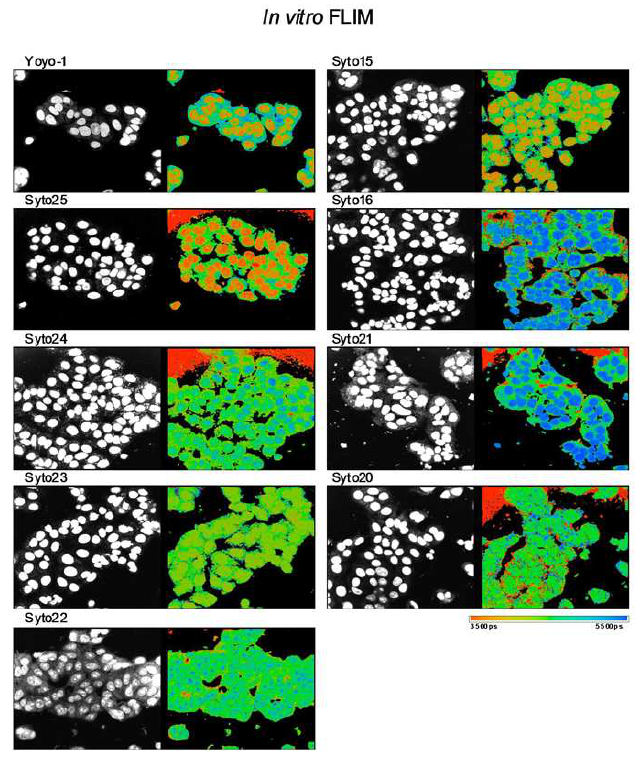
Figure 4. In vitro Fluorescent Lifetime Imaging Microscopy (FLIM): Discrimination of cellular DNA and RNA. Intensity (left panel) and lifetime images (right panel) of MCF-7 cells stained with a range of green-fluorescent nucleic acid binding dyes. The dyes are commonly used as nuclear or cell counter stains in standard fluorescent microscopy (left panel) but are known to differ from each other in one or more characteristics, including DNA/RNA binding selectivity. Here, additional contrast provided by FLIM of Syto15 and Yoyo-1 distinguished cytoplasm, nucleus and nucleoli. Contrast observed with Yoyo-1 is due to longer lifetime of dye bound to RNA and shorter lifetime of dye bound to DNA (data not shown). FLIM contrast observed with other dyes was either minimal (Syto23) or offered less contrast across cytoplasmic, nuclear and nucleolar compartments (Syto25, Syto16, Syto21, Syto22, Syto20). This study identified dyes appropriate for rapid cell image segmentation using FLIM rather than requiring dye multiplexing in either live or fixed cells and suggests that additional screening to identify FLIM contrast for biological event monitoring e.g. apoptosis or cellular differentiation may be worthwhile. Images acquired by Clifford Talbot et al. in the Photonics Group at Imperial College London using a laser scanning confocal TCSPC